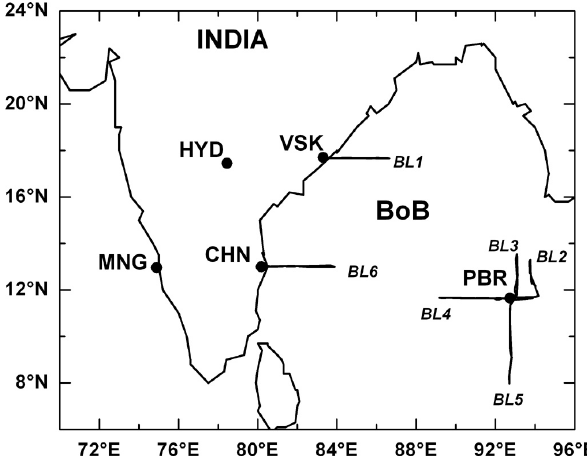
Fig. 1. Ground projection of the aircraft flight track during BL sor- ties along with the base stations overlaid on the Indian subconti- nent map. Solid dots represent the geographical location of the base